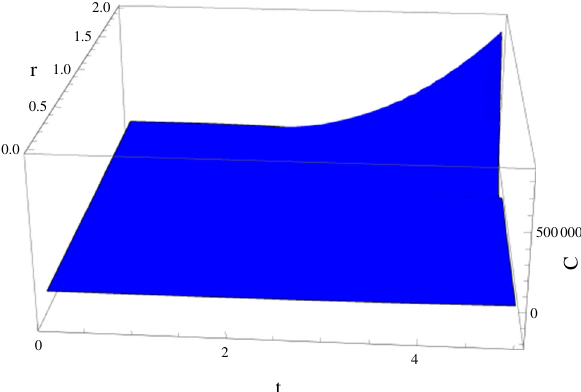
Fig. 2 Plots of C versus t and r for κ = 0 and m = 1 . 4, represents flat